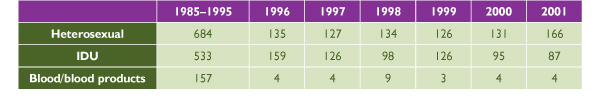
Number of Positive HIV Test Reports among Adult Females (≥ 15 Years), by Year of Test and Exposure Category, 1985–2001 Source: Data from HIV and AIDS in Canada, Surveillance Report to December 31, 2001